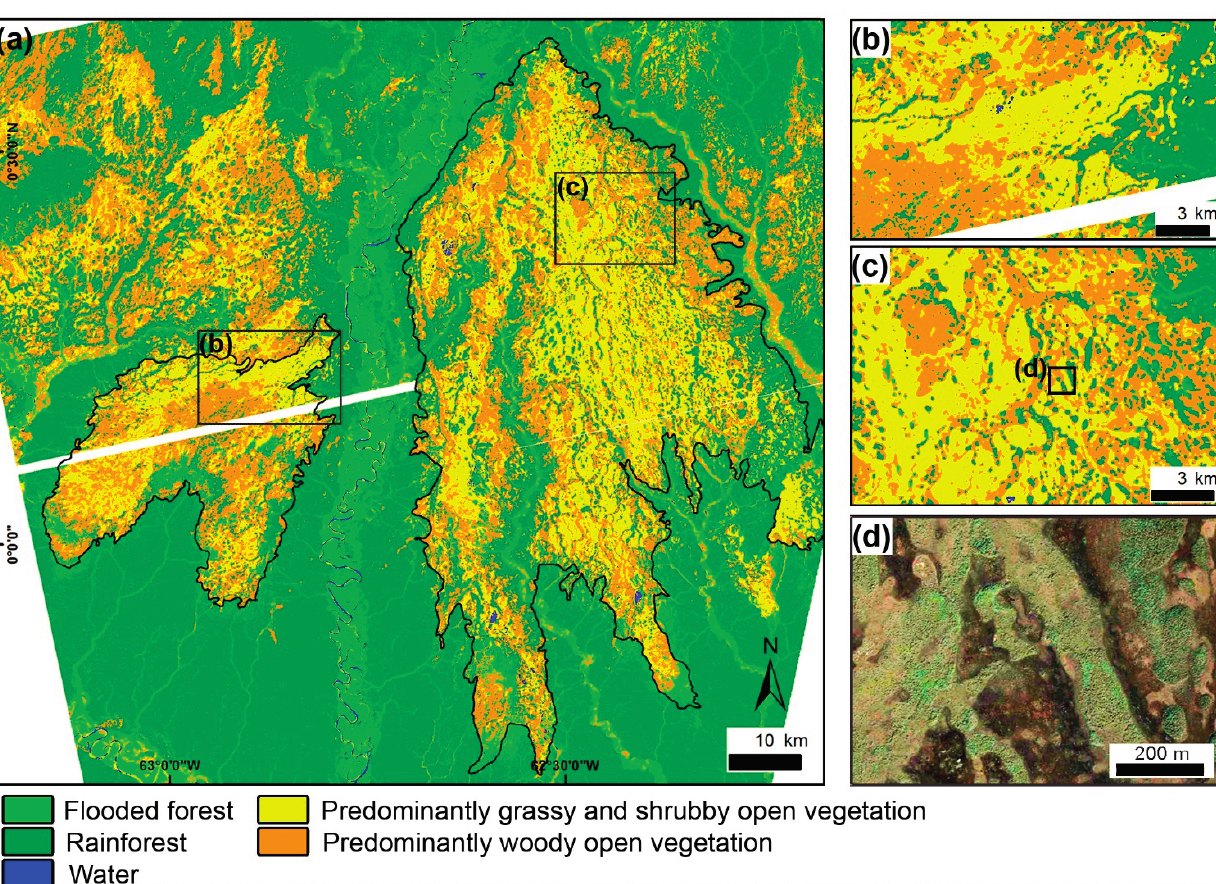
Figure 6. ( a ) Phytophysiognomic map of the study area derived from the application of a decision tree integrating TM/Landsat and PALSAR images. Note that the main area of